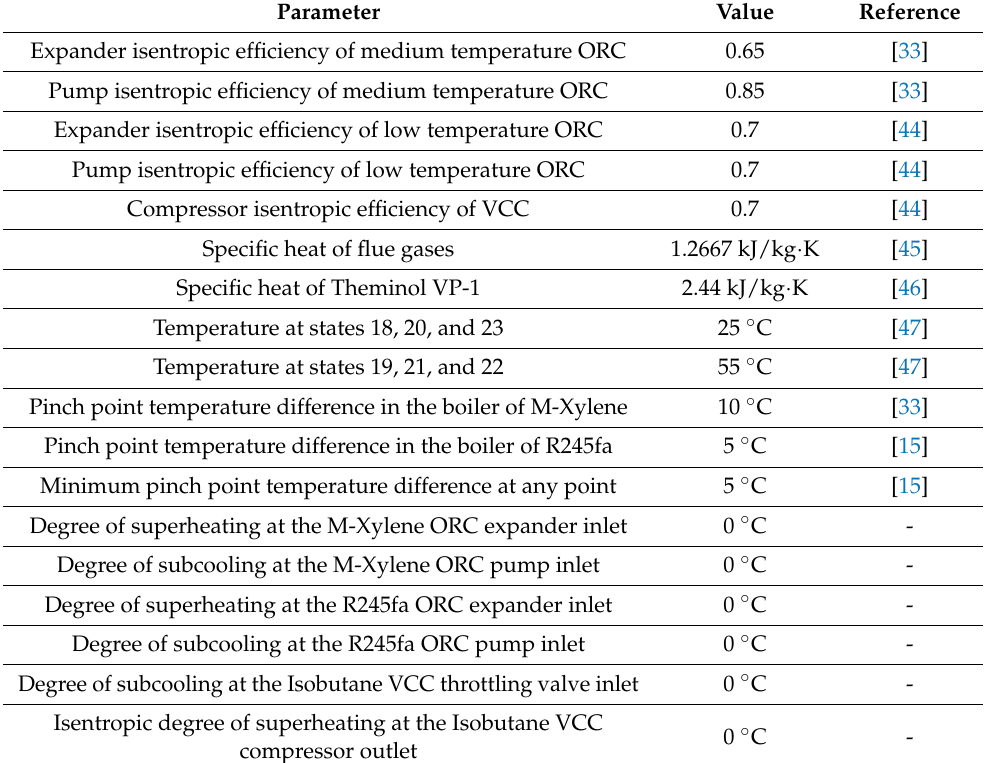
Table 1. Assumptions of parameters for the analysis.